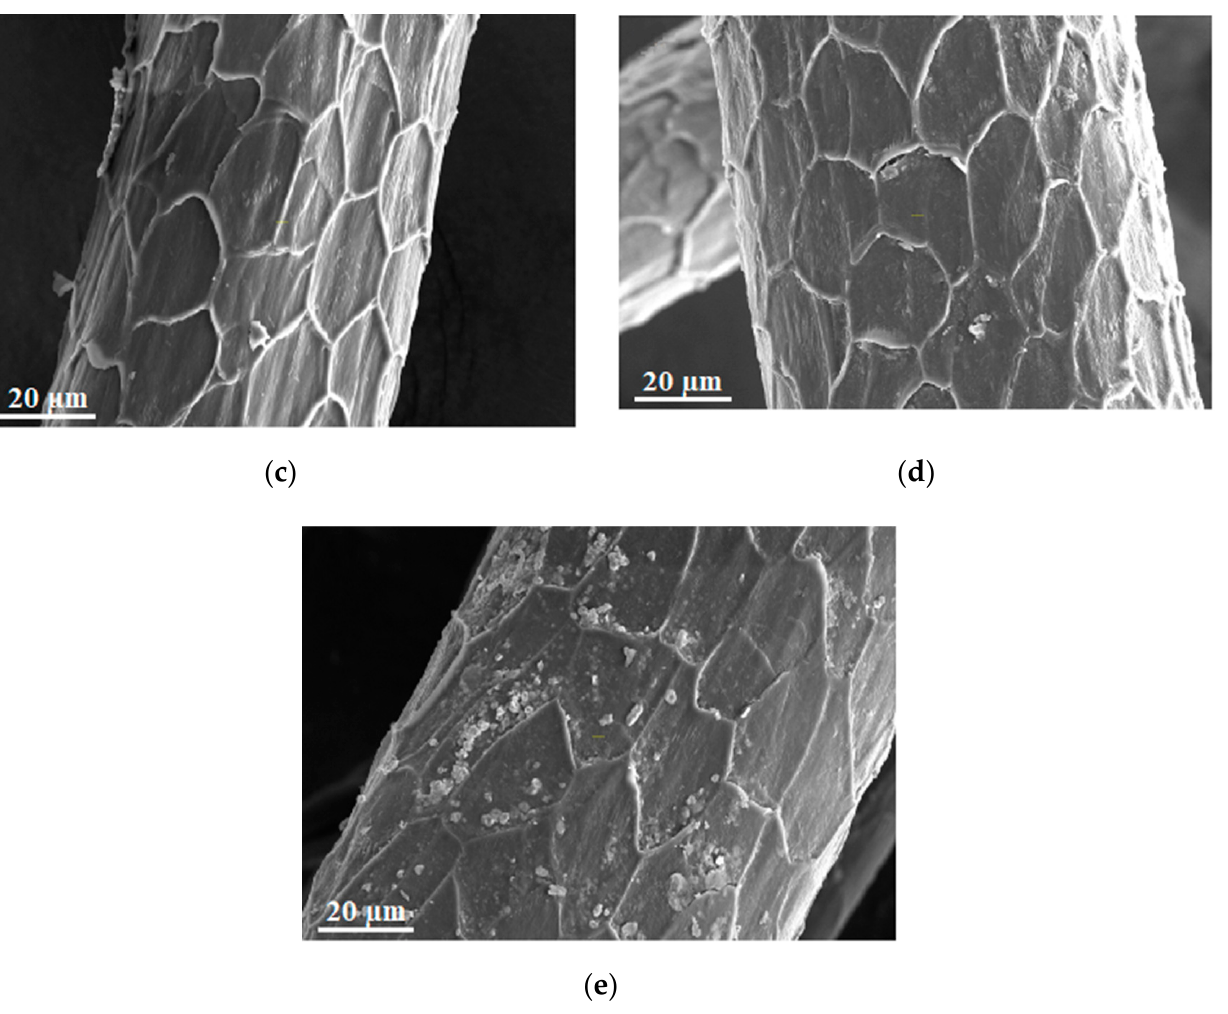
Figure 1. SEM images of: ( a ) pristine wool fibers, ( b ) oxidized wool fibers, ( c , d , e ) oxidized wool fibers loaded with Cu 2+ , Cd 2+ , respectively Pb 2+ .